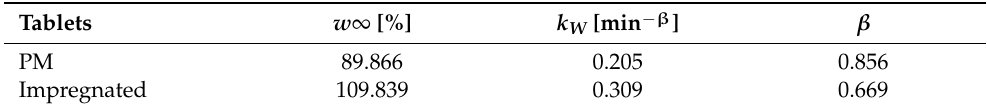
Table 2. Optimal parameters of Weibull model for tablets prepared from physical mixture (PM) and from impregnated